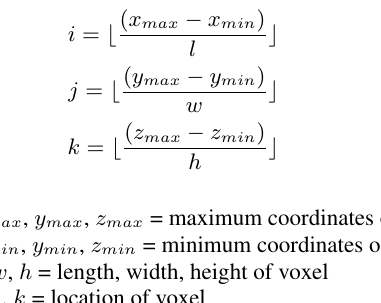
Figure 4. Feature